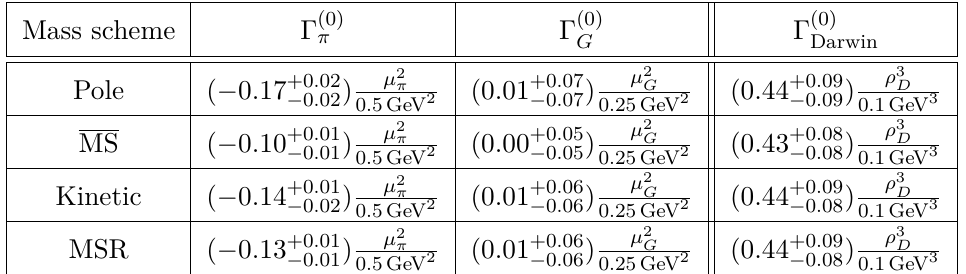
and ρ 3 in units , µ 2 π G D